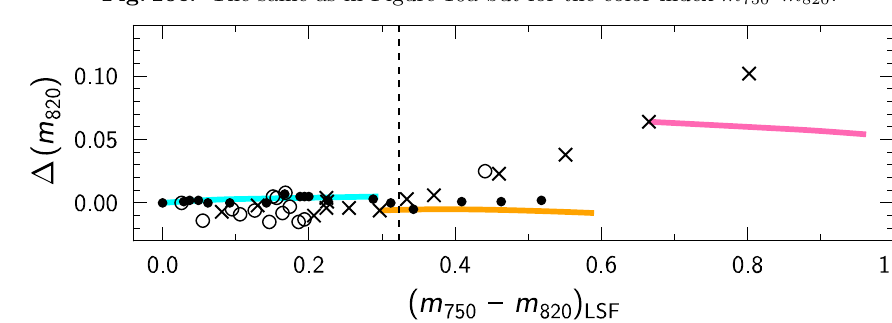
Fig. 10c. The same as in Figure 10a but for the color index m 750 – m 820 .